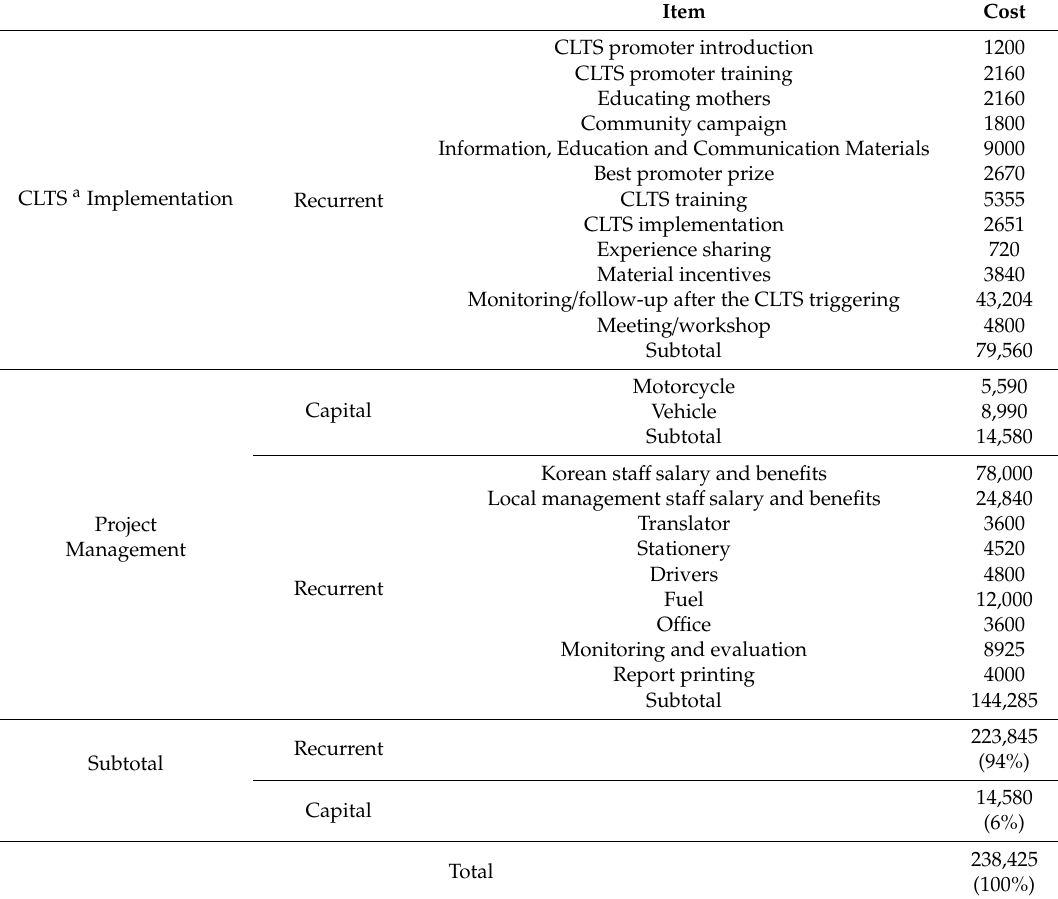
Table 4. Initial costs (program implementation and management, Int’l